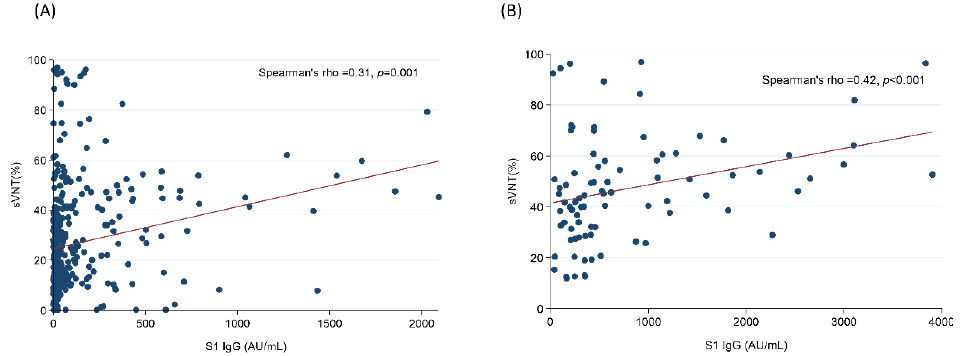
Figure 2. The correlation coefficient between the anti-S1 IgG and sVNT in the hemodialysis ( A ) group, and the control ( B ) group.